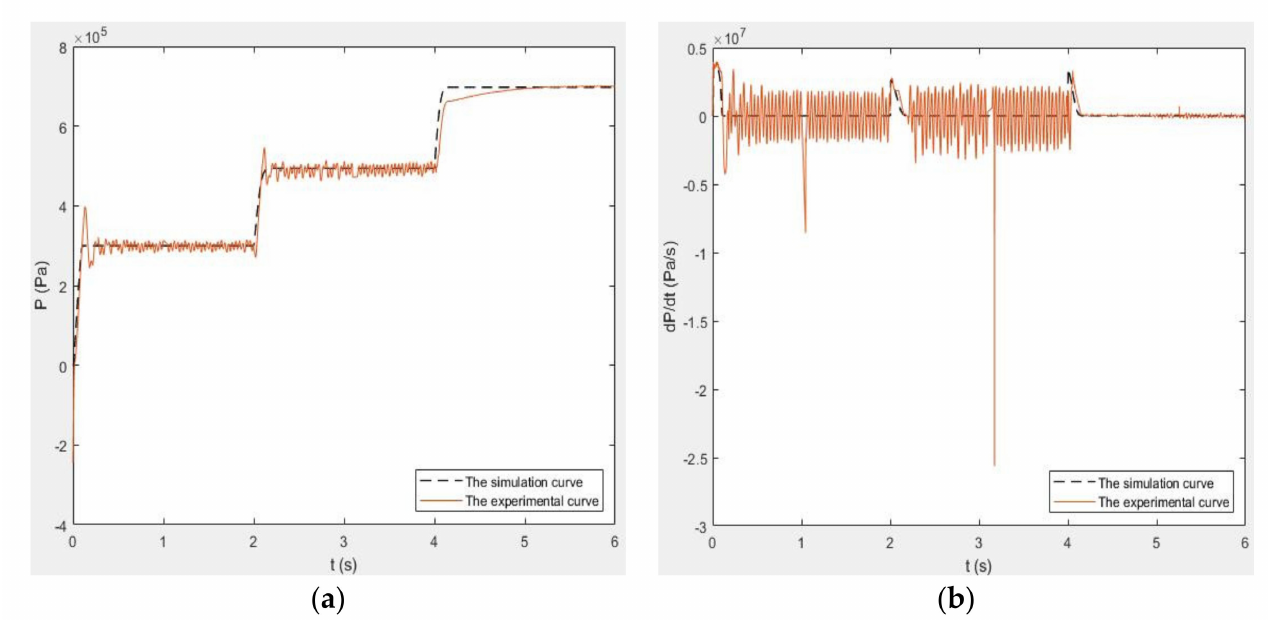
Figure 9. Step-pressurization response of an automatic pressure regulating valve: ( a ) pressure response; ( b ) pressure change rate